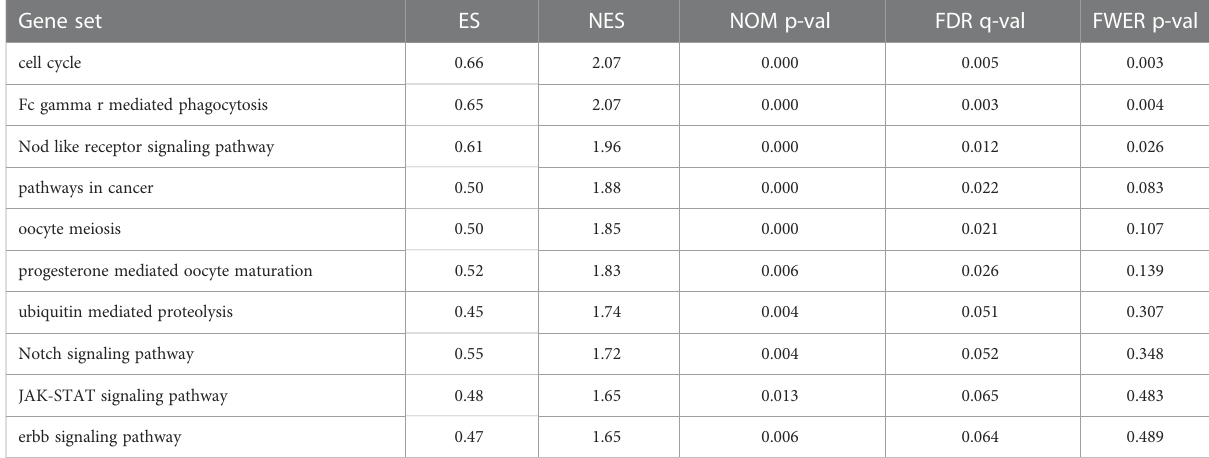
TABLE 1 The high-risk group enriched gene sets.